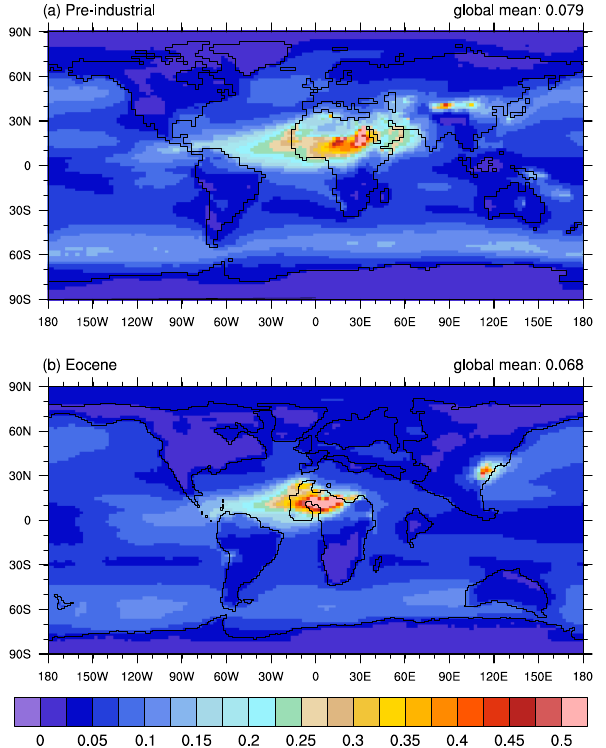
Figure 7. (a) Pre-industrial and (b) Eocene aerosol optical depth (unitless) simulated by the Community Atmosphere Model 4.